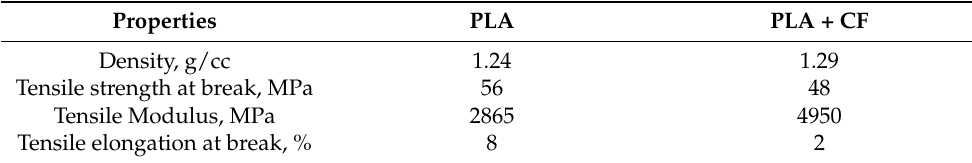
Table 2. Properties of PLA and PLA + F filaments